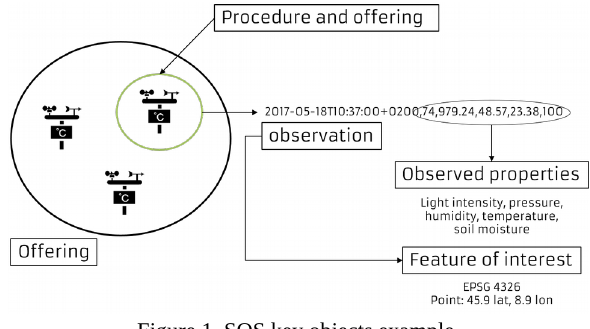
Figure 1. SOS key objects example.